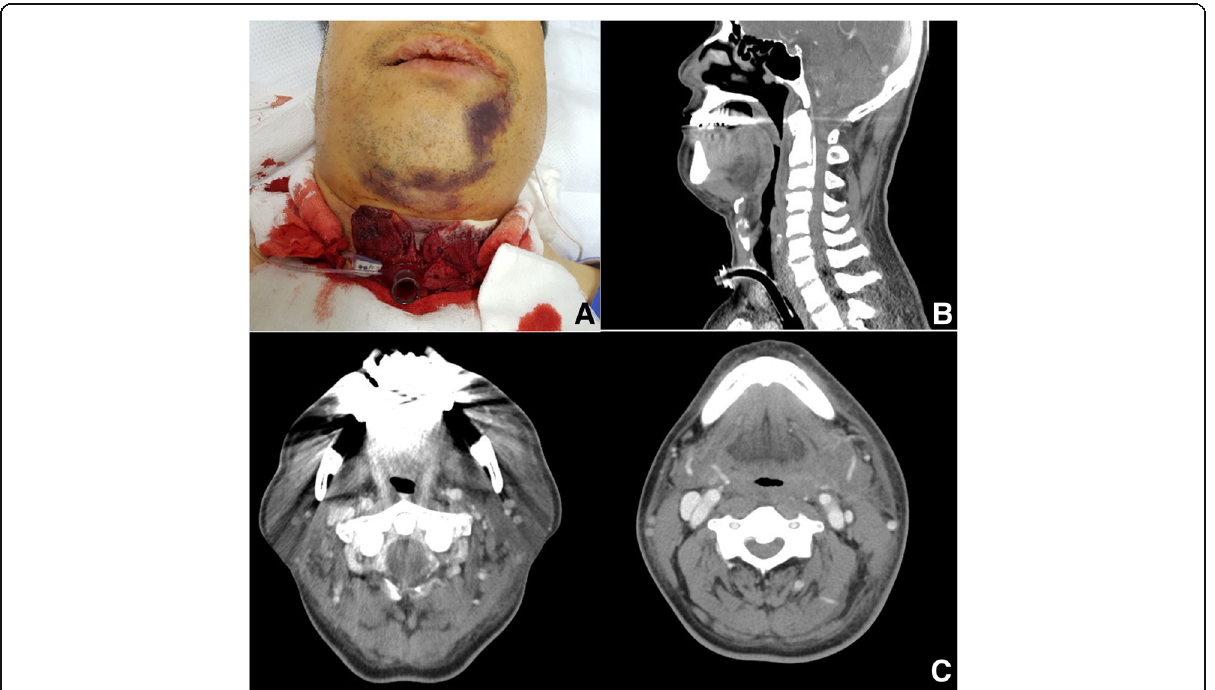
Fig. 2 a Constant bleeding at the tracheostomy site after an emergency tracheostomy. b Follow-up sagittal CT view and c axial CT views after 3 days showed decreased soft tissue swelling along the superficial and deep neck spaces at 3 days after